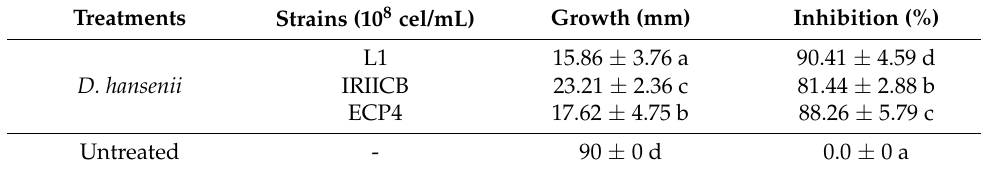
Table 1. Inhibition of mycelial growth of B. cinerea under application of D. hansenii strains. Treatments Strains (10 8 cel/mL) Growth (mm)